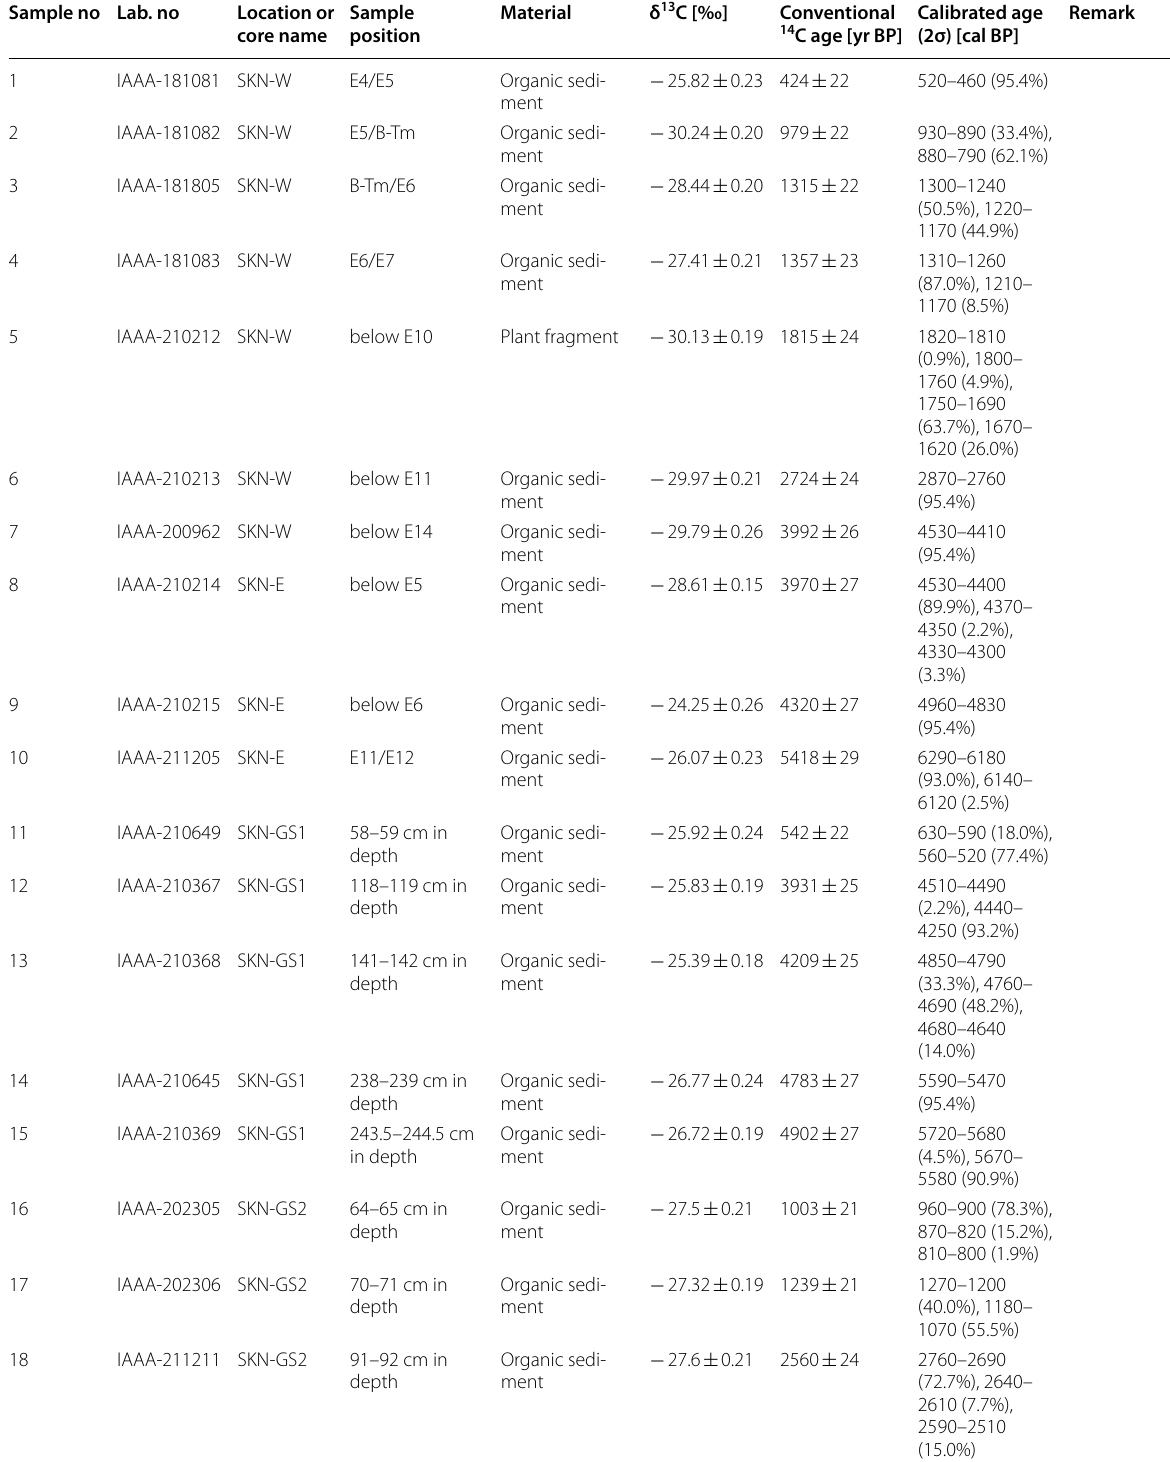
Table 5 Results of radiocarbon dating of samples in SKN-E, SKN-W, and SKN-GS Sample no Lab.